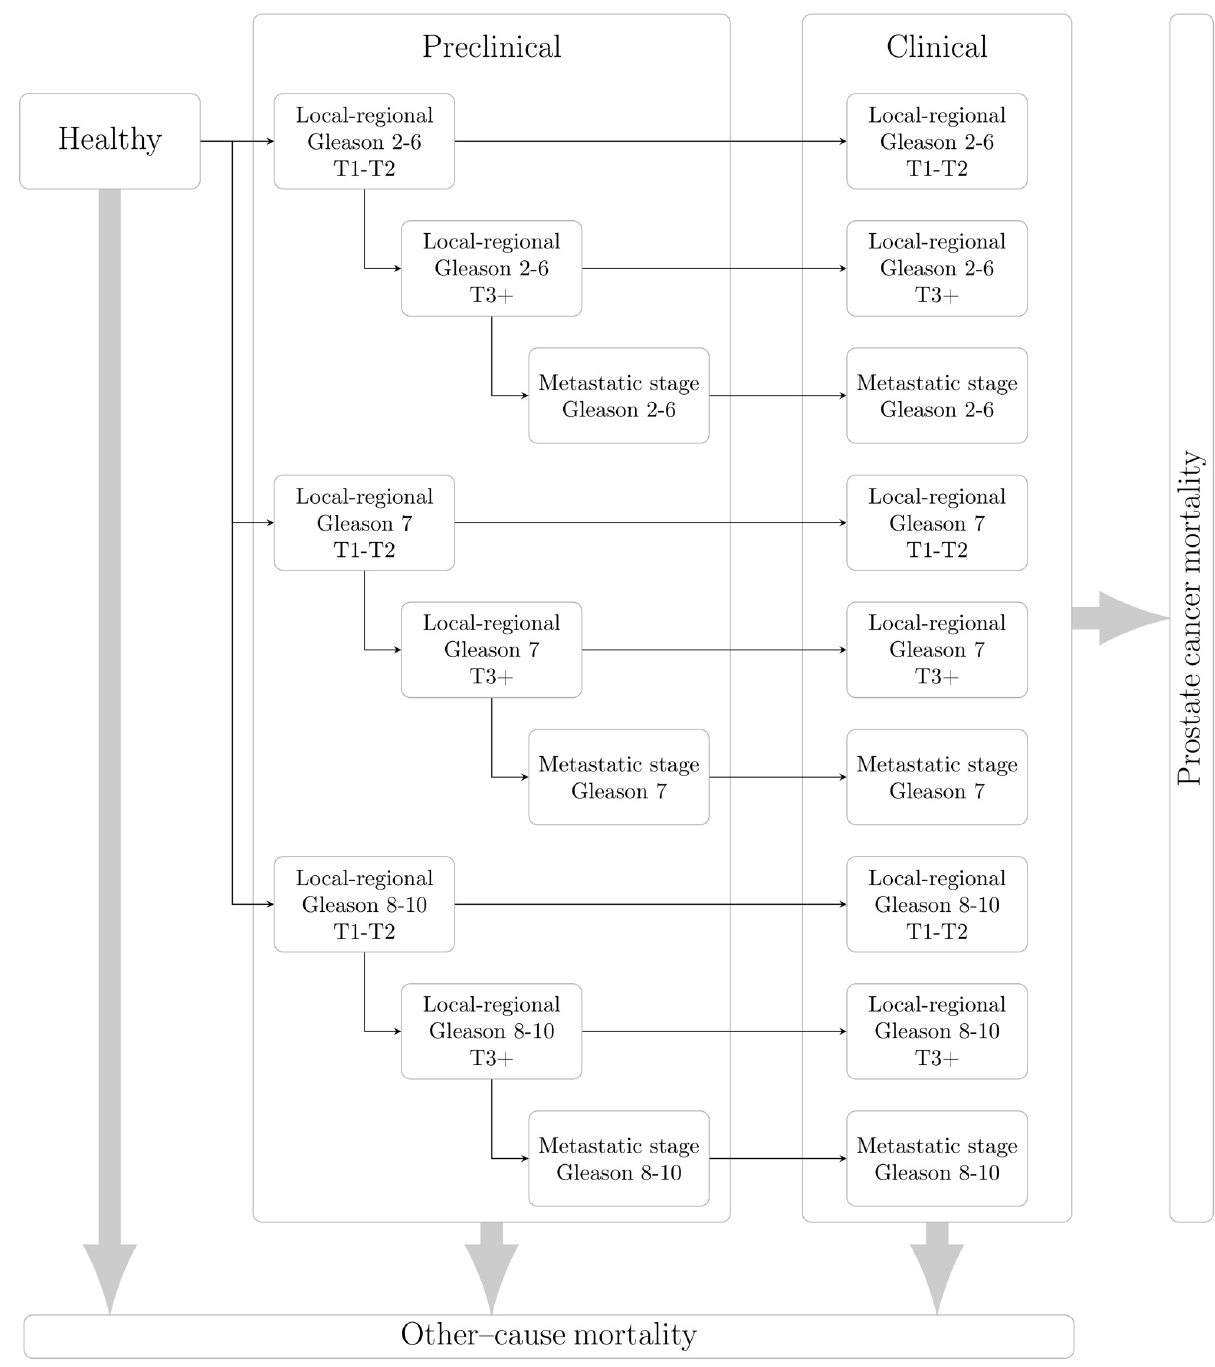
Fig 2. Schematic of the prostate cancer natural history model. Individuals are assumed to be disease-free at age 35 years. They may progress to preclinical cancer states with a fixed Gleason score, with progression by T-stage and to metastatic cancer. Preclinical cancers may be diagnosed from nine different states, with survival from prostate cancer death evaluated from the possibly counterfactual time of clinical diagnosis. Death due to other causes is represented as a competing event.